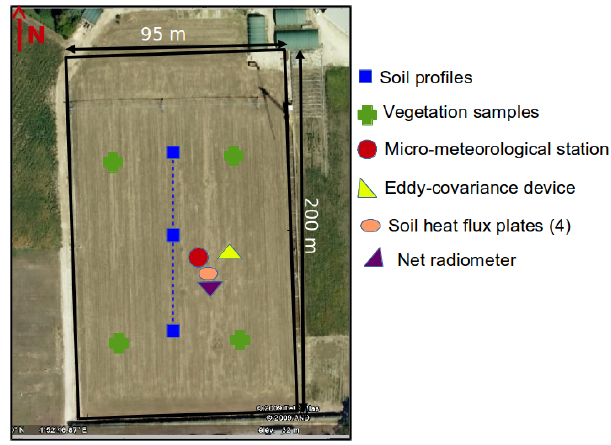
Figure 1. Map of the field site and locations of the instruments. Image from Google Earth,